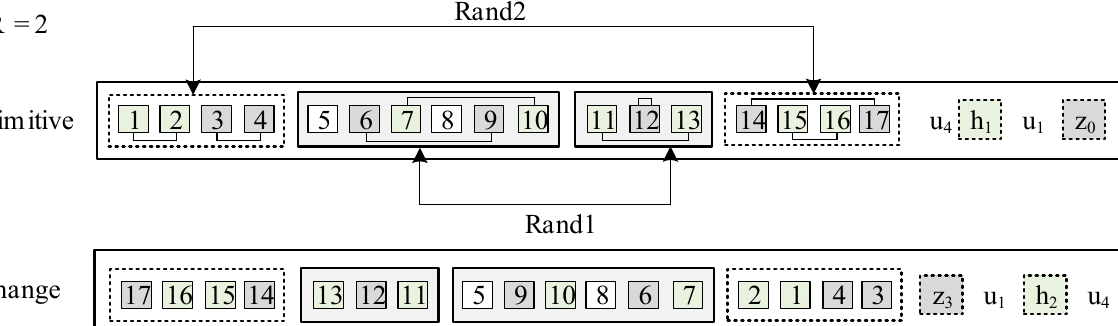
Figure 7. Adaptive olfactory search.